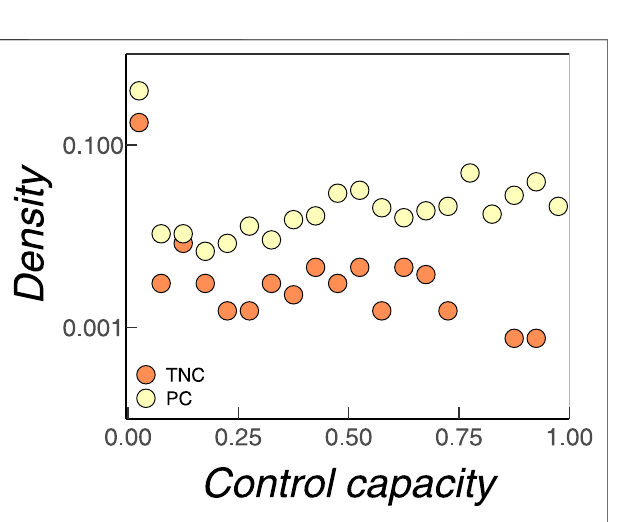
FIGURE 4 | Distribution of control capacities K i for TNCs (red) and PCs